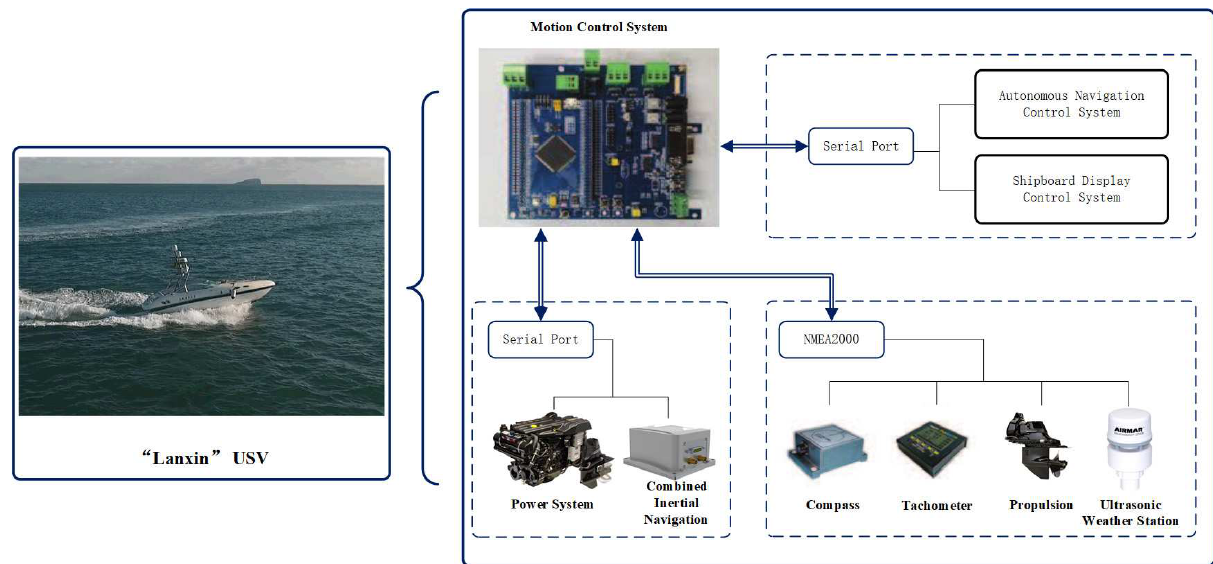
Figure 3. The Shipborne Sensors for